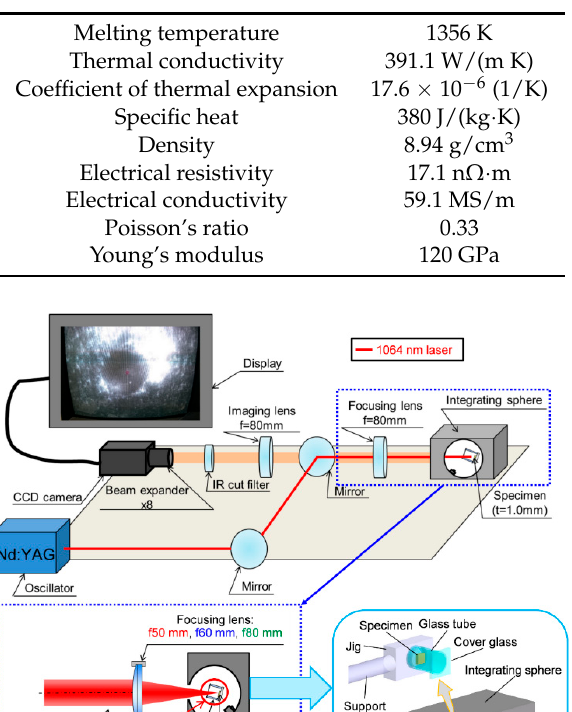
Table 1. Physical properties of copper C1020.